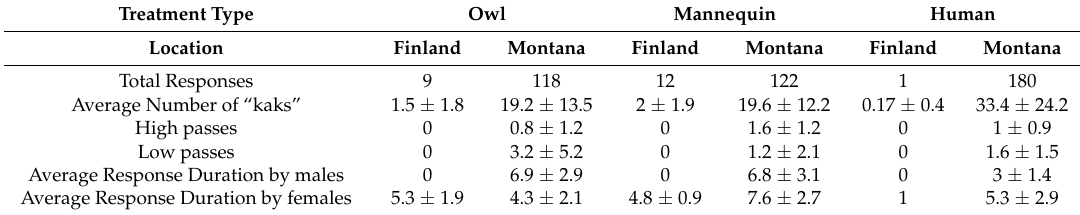
Table 1. Total responses, average (with CI) numbers of responses (“kaks” and passes), and response duration per nest by females and males at nest sites in Finland ( n = 6) and Montana ( n =